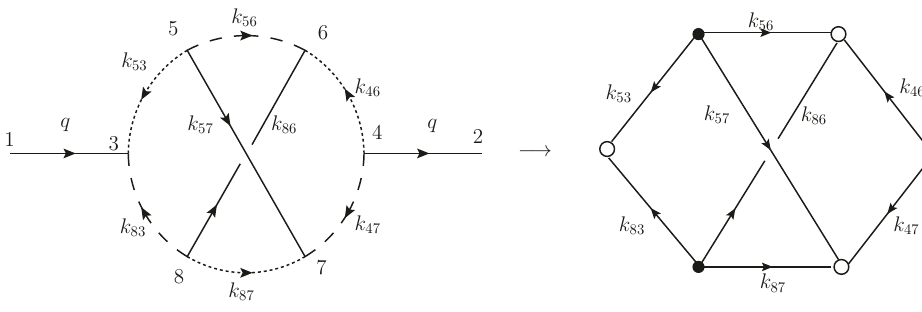
Figure 12 . On the left, a Feynman super-diagram involving only chiral/anti-chiral lines. On the right, the corresponding (cid:18) -graph encoding the Grassmann integrals. The two \external" propagators with momentum q do not play a r^ole in the bipartite graph because the external states are the lowest components of the chiral and anti-chiral super(cid:12)elds, and so the corresponding Grassmann variables are set to 0.